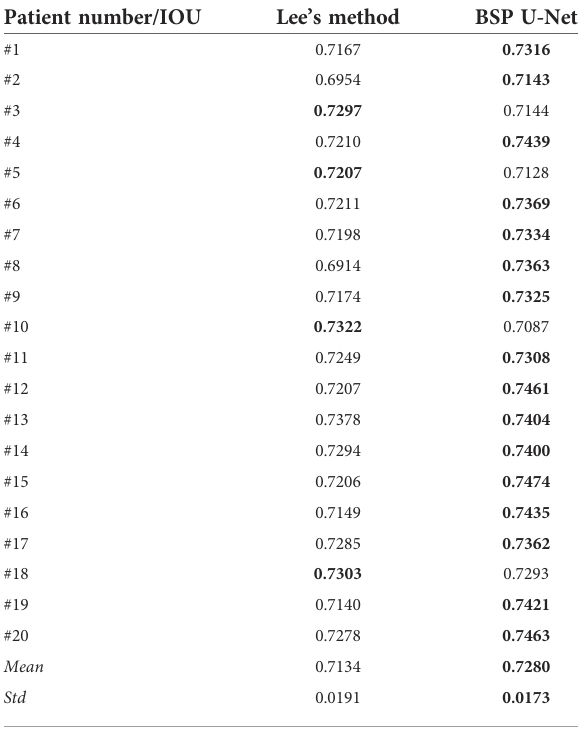
Bold values means best values.